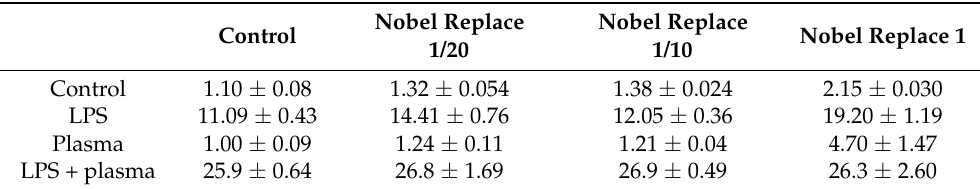
Table 3. Analysis of the expression level of CD54 molecule on the surface of THR-1 cells after 24 h of incubation with NSMP from the Nobel Replace